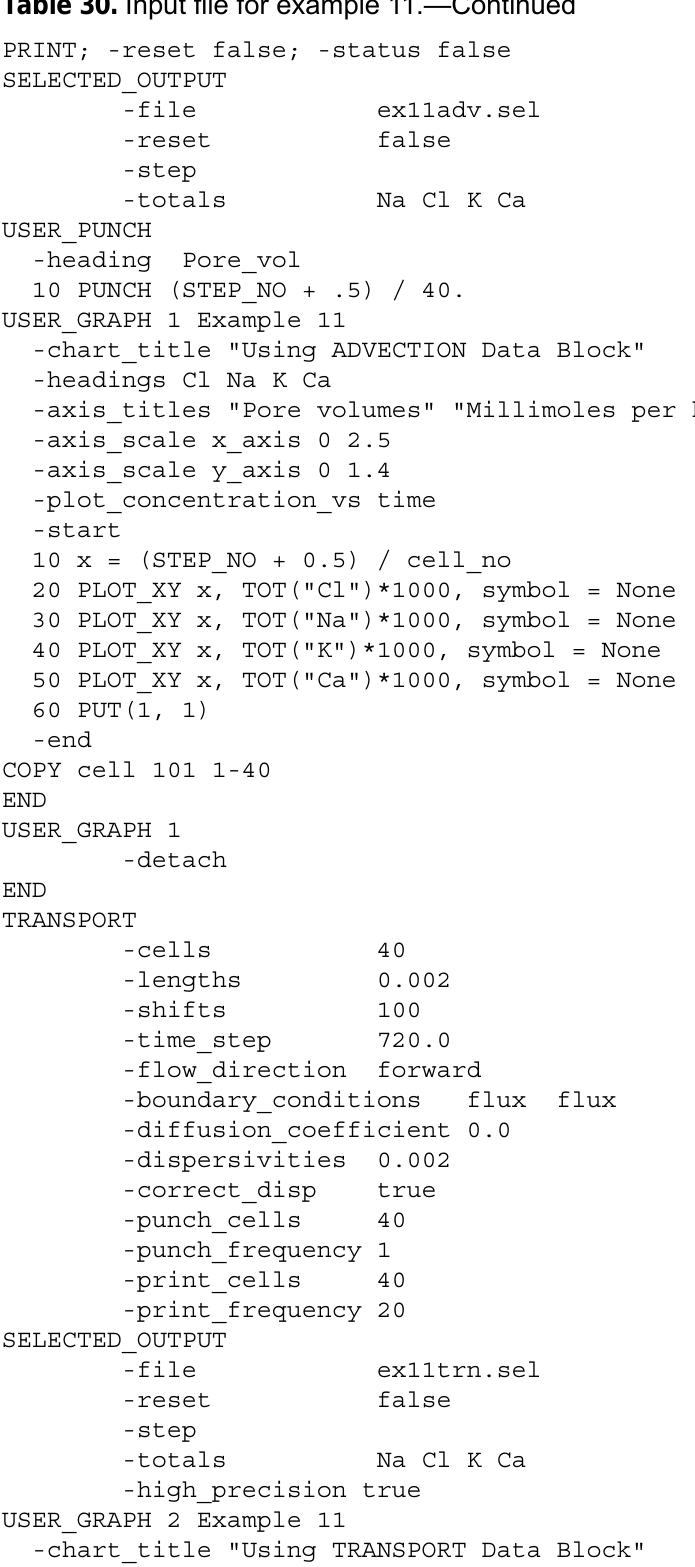
Table 30. Input file for example